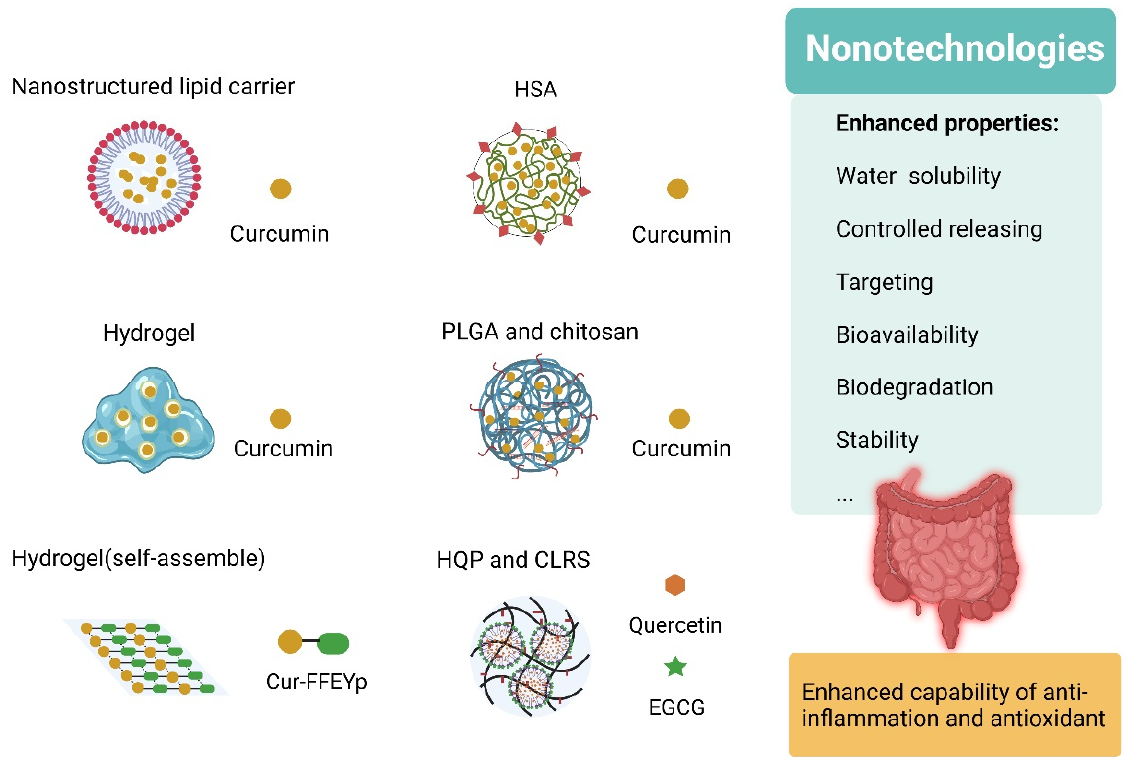
Figure 6 . Nano-strategies in IBD treatment. Multiple nano-carriers, including nanostructured lipid carriers, degradable hydrogels, and nonimmunogenic protein-based nanocarriers, have been widely utilized to precisely deliver polyphenols. Strategies for the codelivery of polyphenols with other drugs have also been exploited to amplify the application of polyphenols in IBD treatment.